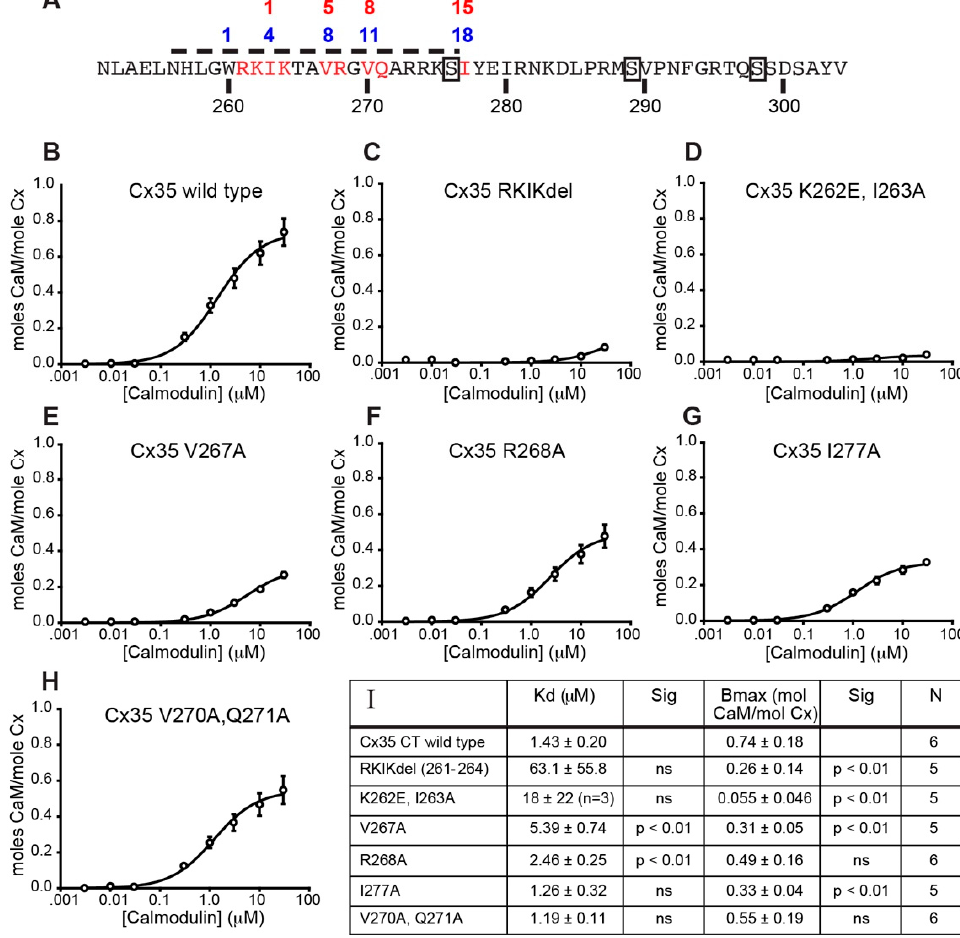
Figure 3. Mutational analysis of the Cx35 C-terminal calmodulin binding site. ( A ) Amino acid sequence of the perch Cx35 C-terminus. The calmodulin binding site identified by Burr et al. [20] is indicated by the dashed line. Putative hydrophobic anchor residues beginning with I263 are numbered above the sequence in red; an alternative set of anchor residues based on Siu et al. [21] is numbered above in blue. Residues highlighted red were studied by mutagenesis. Boxes indicate protein kinase phosphorylation sites that have been mapped. ( B ) Binding curve for wild type Cx35 C-terminus fit with a ligand binding model. Data are means ± SEM of 6 experiments. Best fit binding parameters are shown in ( I ). ( C – H ) Binding curves for Cx35 C-terminus mutants; the mutations are indicated in the title of the panel. Data are means ± SEM for 5 to 6 experiments. ( I ) Best-fit first-order binding parameters and n of experiments performed for each of the constructs shown in ( B – H ) Statistical comparisons to Cx35 wild type using Brown-Forsythe ANOVA with Dunnett’s multiple comparisons are also shown.